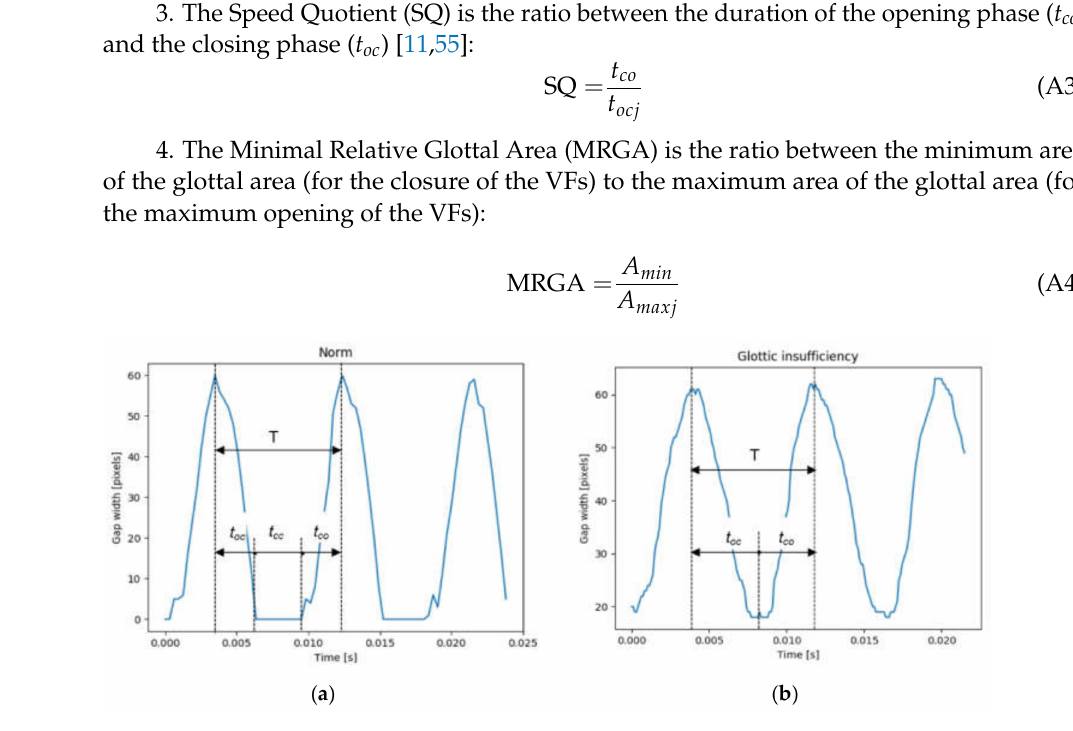
Figure A1. Example glottal width waveforms for a normophonic subject ( a ) and a patient with glottal insufficiency ( b ). The indicated time intervals are explained in the definitions of the